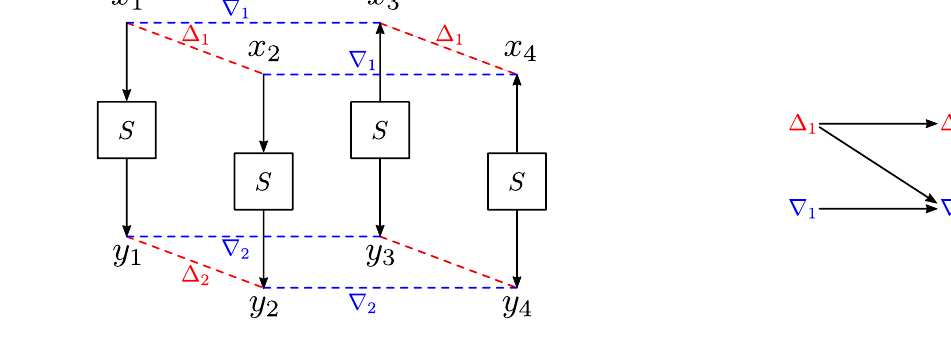
Figure 2: Differences of an S-box on four